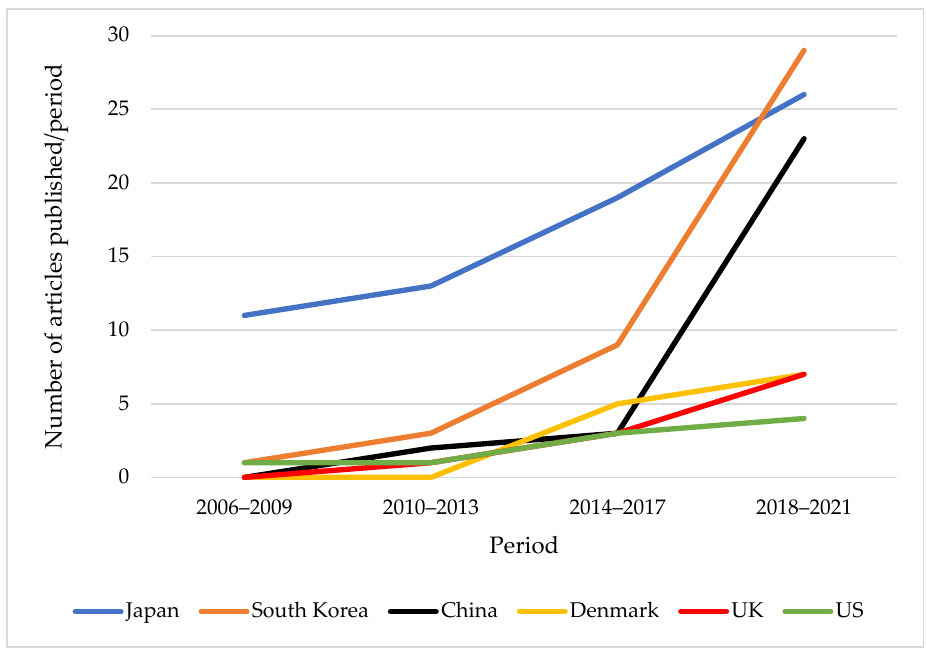
Figure 2. Forest therapy publication trends 2006 – 2021, top 6 countries (67% all articles).